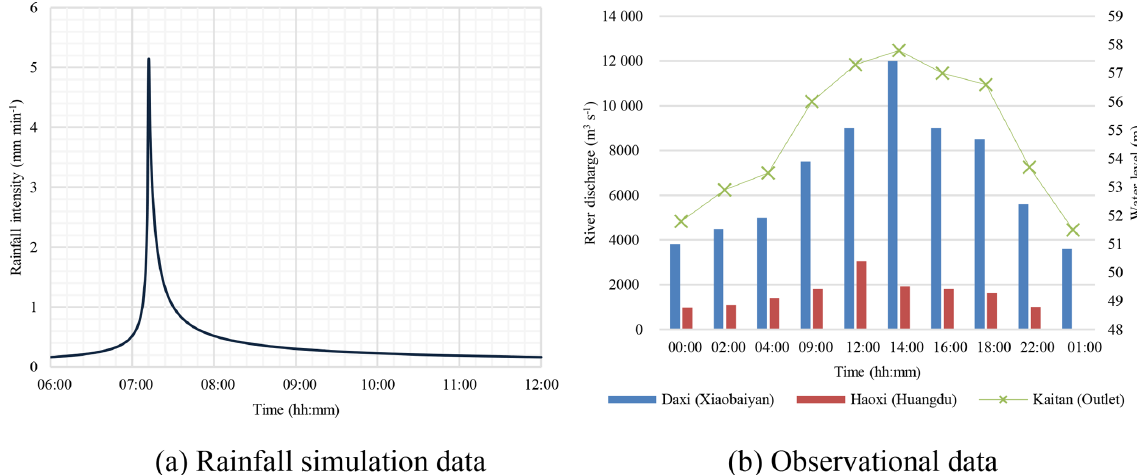
Figure 3. Rainfall simulation results based on the CHM method, and observational data used for fluvial flood